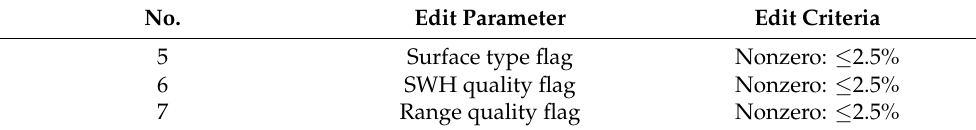
Table 2. The edit criteria of Jason-3 and Sentinel-6 GDR to ensure the data quality. No. Edit Parameter Edit Criteria 5 Surface type flag Range quality flag Nonzero: ≤